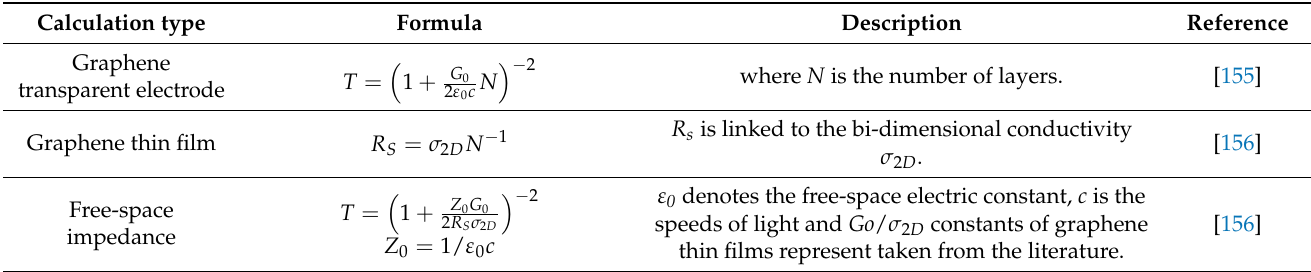
Table 5. Calculation of the thickness of graphene